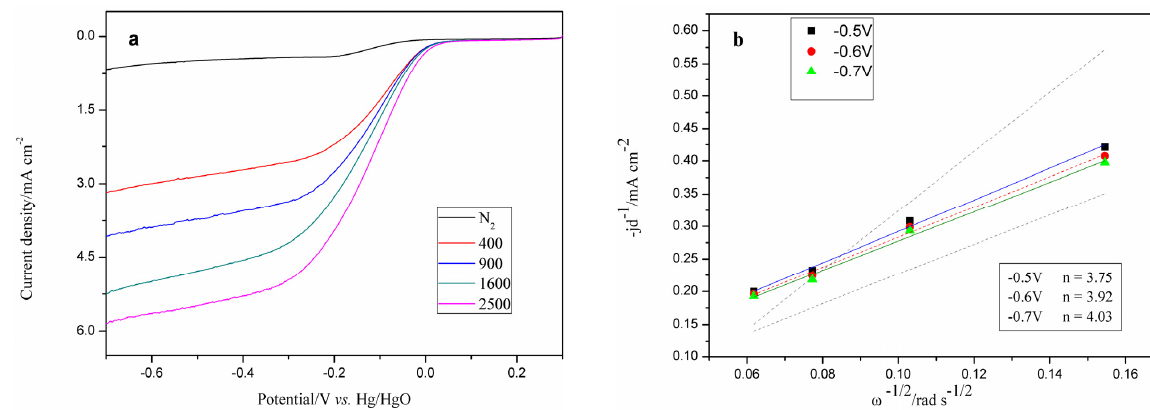
Figure 2. ( a ) Rotating disk electrode (RDE) voltammograms of the Fe–N/C electrode in O 2 -saturated 0.1 M KOH under different rotation rates at a scan rate of 5 mV·s − 1 . ( b ) Koutecky–Levich plots of the Fe–N/C electrode at different